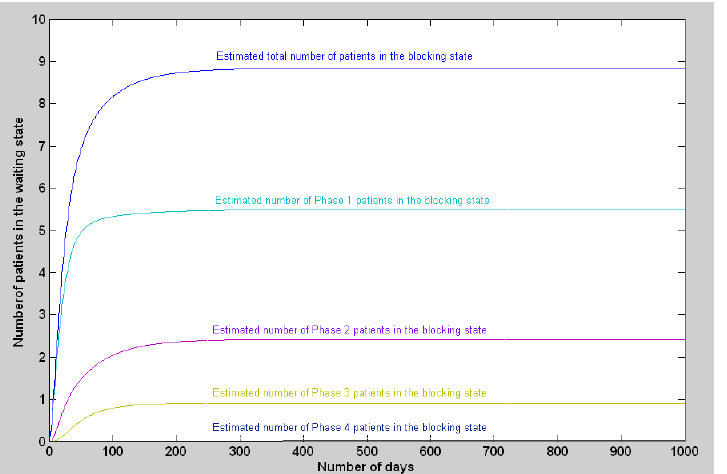
Figure 7. The estimated number of patients in the blocking state from each phase for a mean discharge delay τ = 10 days.